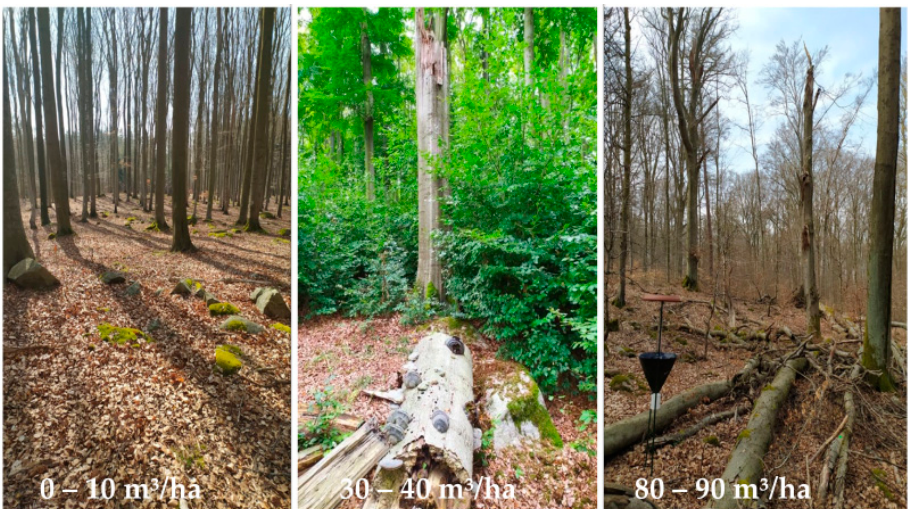
Figure 2. Development of the natural accumulation of deadwood in unmanaged stands within 70 years of abandonment in the University Forest Enterprise of the Czech University of Life Sciences Prague.